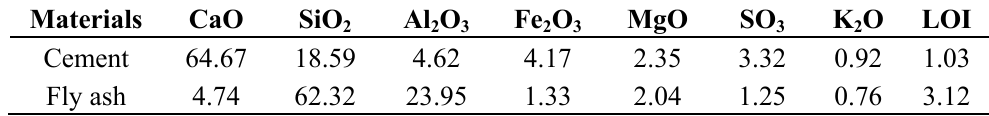
Table 1. Chemical composition of cement (mass%).